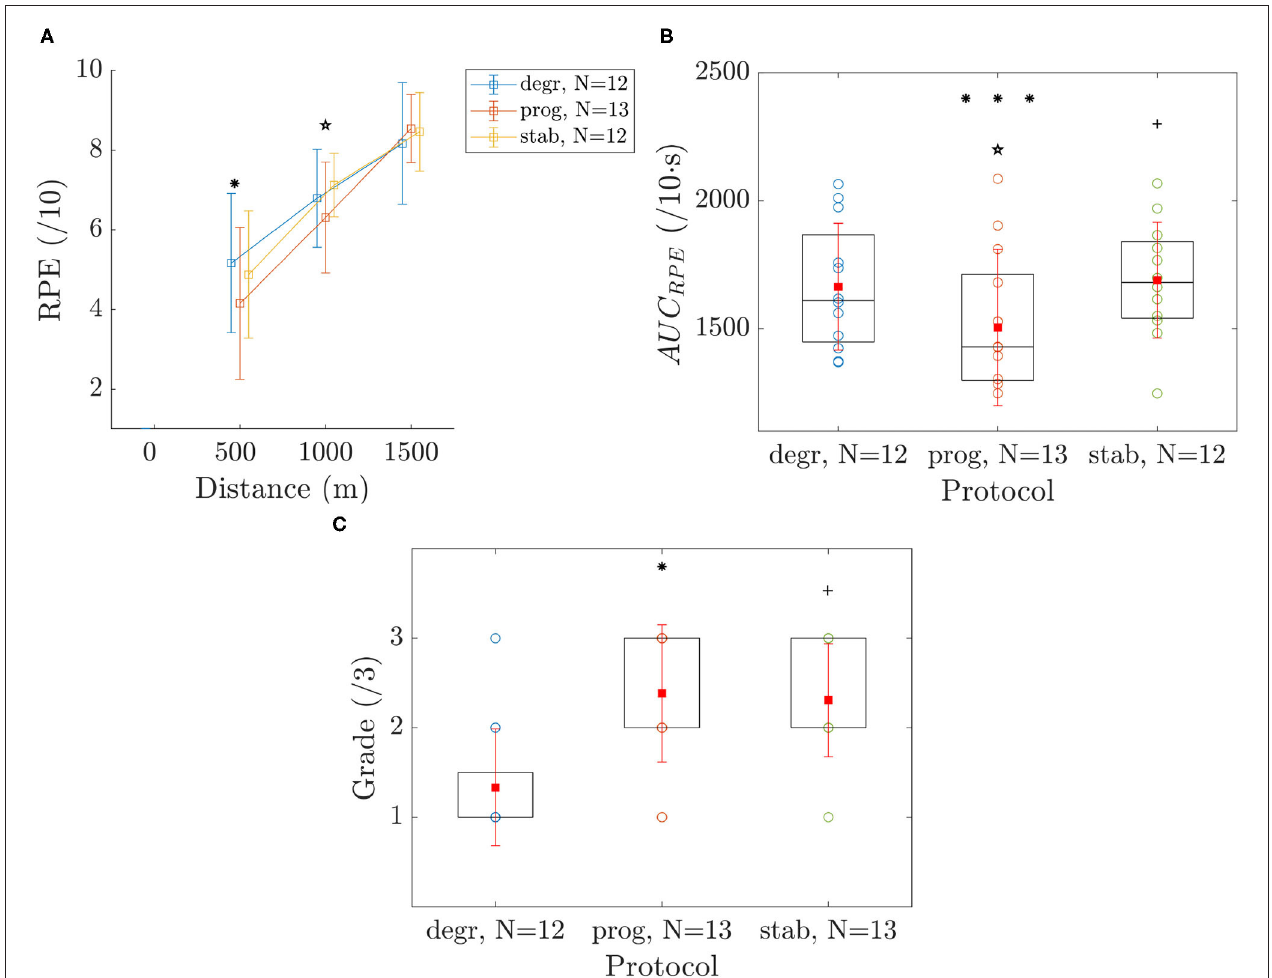
FIGURE 4 | RPE (A) , AUC RPE (B) , and grading of protocol (C) . Values are mean ± SD. The symbols ∗ , ⋆ , and + indicate a significant difference between degr - prog , prog - stab , and stab - degr , respectively. The number of symbols (one, two, or three) indicate the p -value ( < 0.05, < 0.01, and < 0.001,